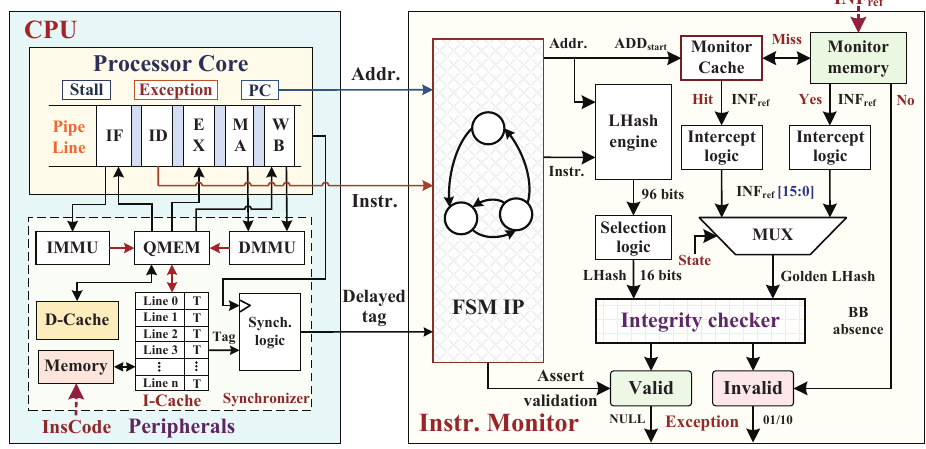
Figure 5. The hardware implementation details of the instruction